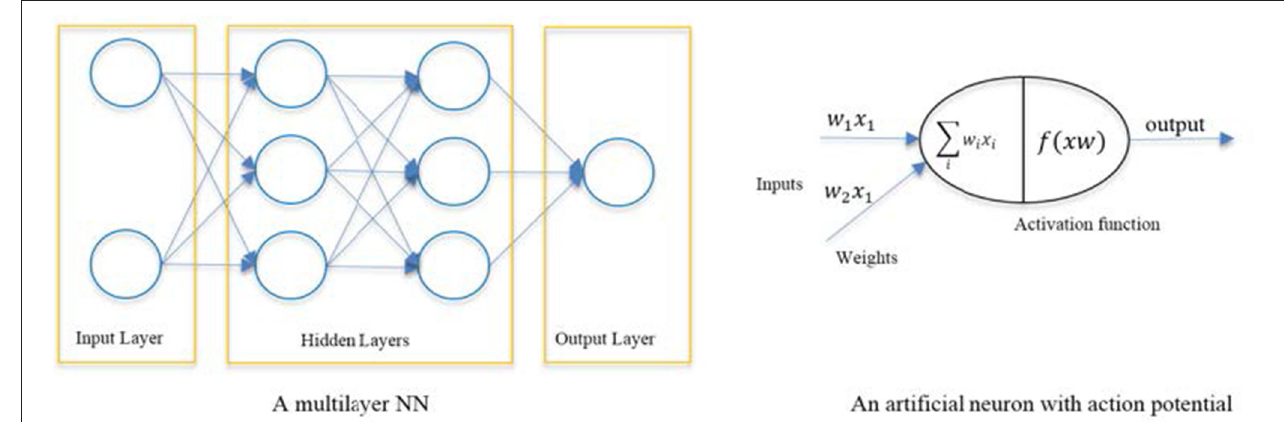
FIGURE 3 | Block diagram showing components of an artificial